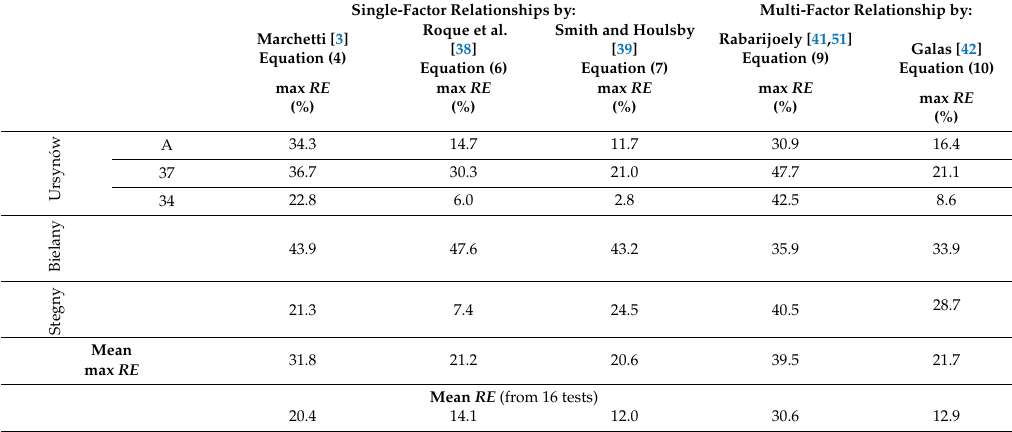
Single-Factor Relationships by: Multi-Factor Relationship by: Roque et al. Smith and Houlsby Marchetti [3] Rabarijoely [41,51] [38] [39] Equation (4) Equation (9) Galas [42] Equation (6) Equation (7) Equation